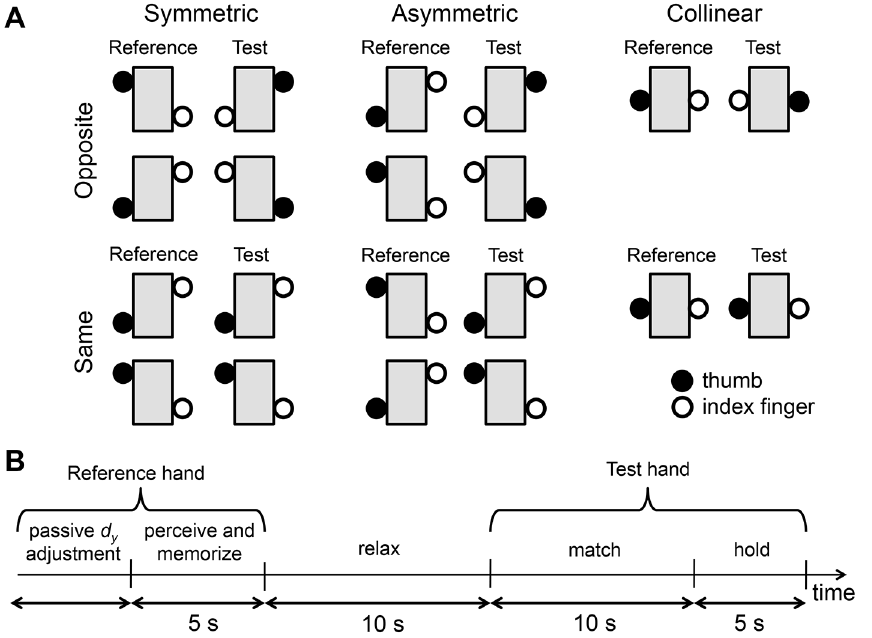
Figure 2. Experimental conditions and trial timeline. Panel A shows all experimental conditions. The thumb and index finger of the reference hand were positioned at one of the three target vertical distances ( d y ; see Figure 1) and subjects were asked to reproduce d y after a 10-second delay using either the opposite hand (test hand) (‘‘Opposite’’ condition) or the same hand (reference hand) (‘‘Same’’ condition). For both Opposite and conditions, subjects were asked to either reproduce d y using the congruent reference hand posture (‘‘Symmetric’’ condition) or an inverse posture (‘‘Asymmetric’’ condition) (see text for more details). Note that the collinear d y requires subjects to use the same posture with both hands. Panel B shows the trial timeline. In the phase of ‘‘passive d y adjustment’’, the digits were passively placed to one of three digit positions. Once the desired d y was reached and digit force was controlled, recoding of reference hand d y started while subjects tried to perceive and memorize the reference hand d y for 5 seconds. During the ‘‘relax’’ phase, subjects were asked to retain the remembered d y while relaxing their hands for 10 seconds, followed by the ‘‘match’’ phase in which they had to reproduce that d y with test hand within 10 seconds. The test hand d y was then recorded for 5 seconds while subjects kept the digit position and digit force level (‘‘hold’’ phase).